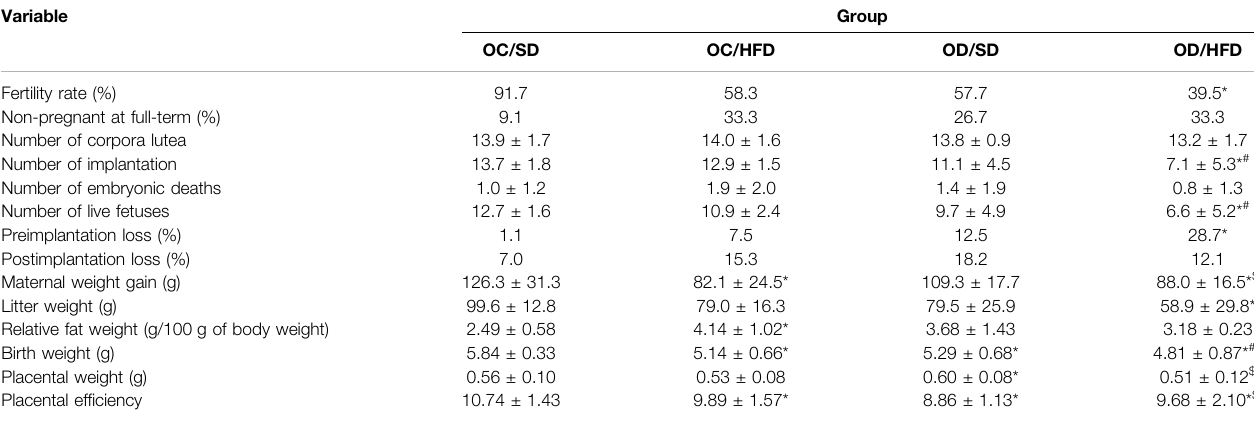
TABLE 1| Maternal reproductive performance,relative fat weight,placentaland birthweight,and placentalef fi ciencyon the21 st day ofpregnancyfrom F1controlpregnant offspring (OC) and diabetic pregnant offspring (OD) that received standard diet (SD) or high-fat diet (HFD) from weaning.